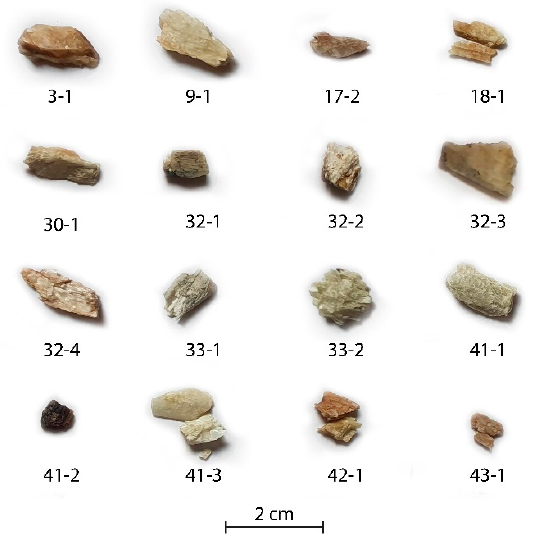
Figure 3. Spodumene crystals (after dividing them into three parts) from the aplite-pegmatites: 3, 9, 17, 18, 30, 32, 33, 41, 42 and 43 (the numbers after the dash correspond to the identification number of the crystal collected from each aplite-pegmatite, since sometimes more than one crystal was collected from the same aplite-pegmatite).